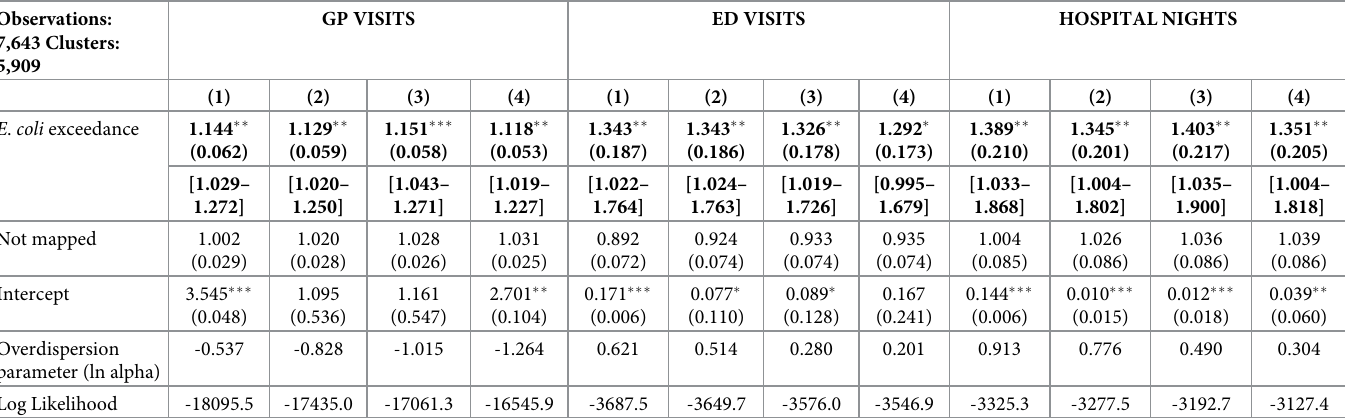
Table 2. Estimation results from negative binomial modelling on outcomes: GP visits, ED visits and hospital nights, estimates reported as incidence rate ratios. Observations: 7,643